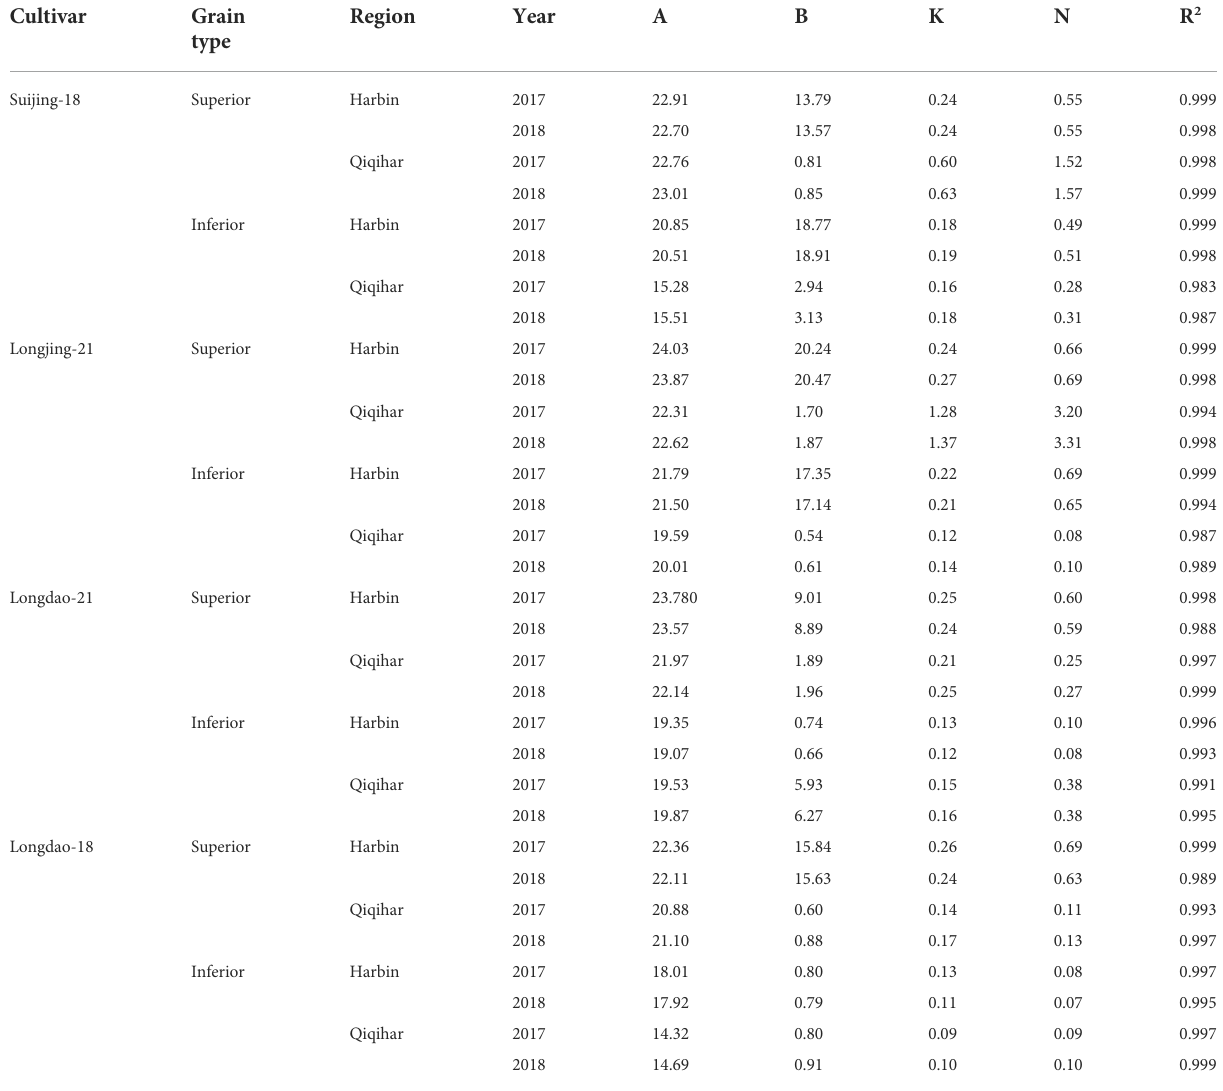
TABLE 2 Parameter estimation of Richard ’ s equation in the rice grain- fi lling process in Harbin and Qiqihar, 2017 and 2018. Cultivar